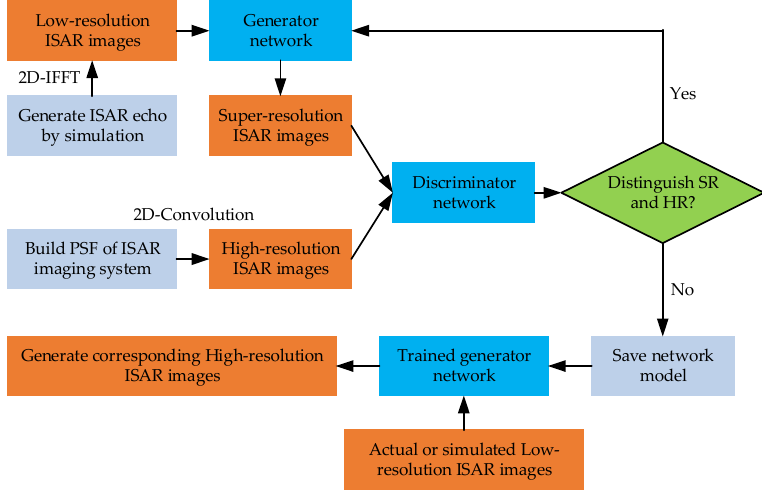
Figure 2. Framework of the proposed GAN for ISAR resolution enhancement.